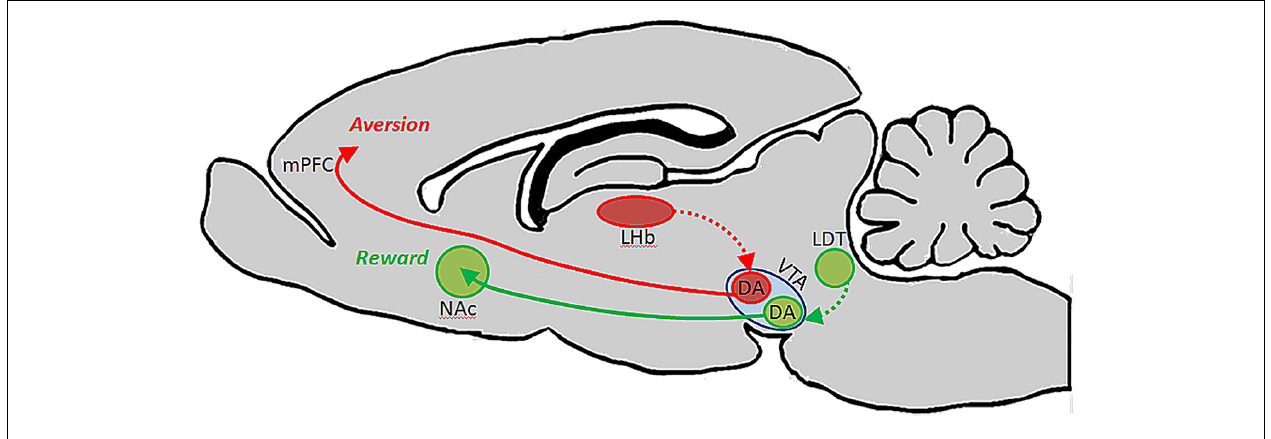
FIGURE 1 |Ventral tegmental area contains functionally heterogeneous subsets of DA neurons. Lammel etal. (2012) showed that DA cells in VTA which receive input from laterodorsal tegmentum (LDT) selectively project to NAc, and their activation